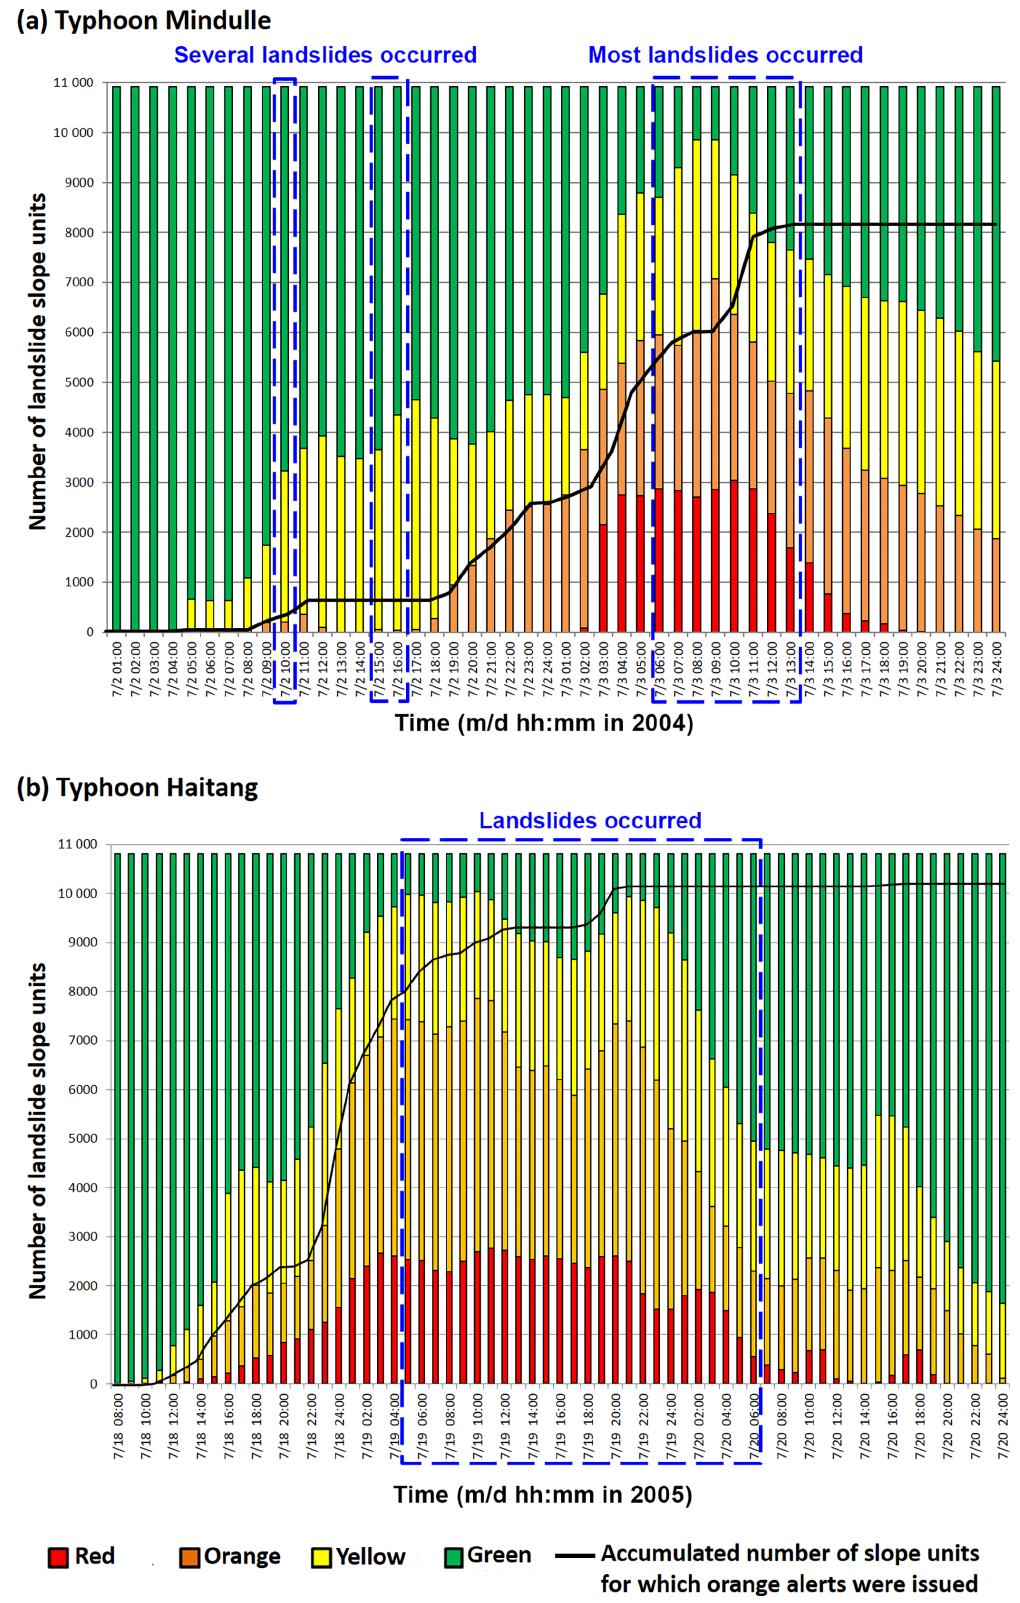
Figure 8. Warning history of (a) Typhoon Mindulle and (b) Typhoon Haitang showing that the time at which our model issued alerts matched the landslide occurrence times reported by